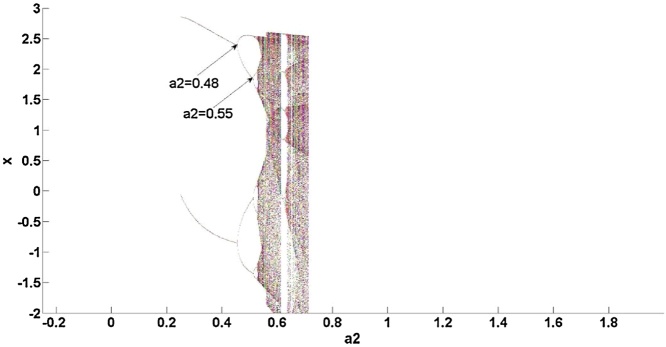
Bifurcation at situation 2.